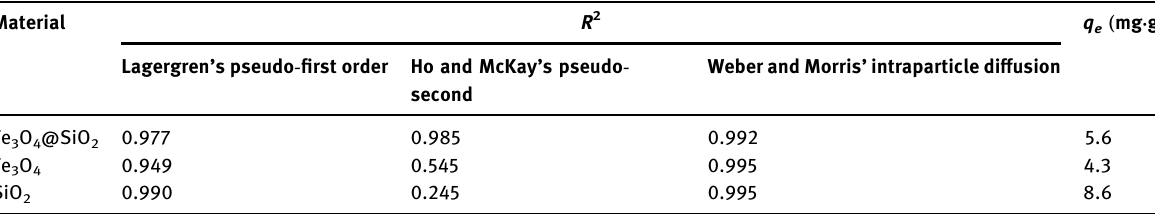
Table 7: Calculated parameters from adsorption kinetics studies Material